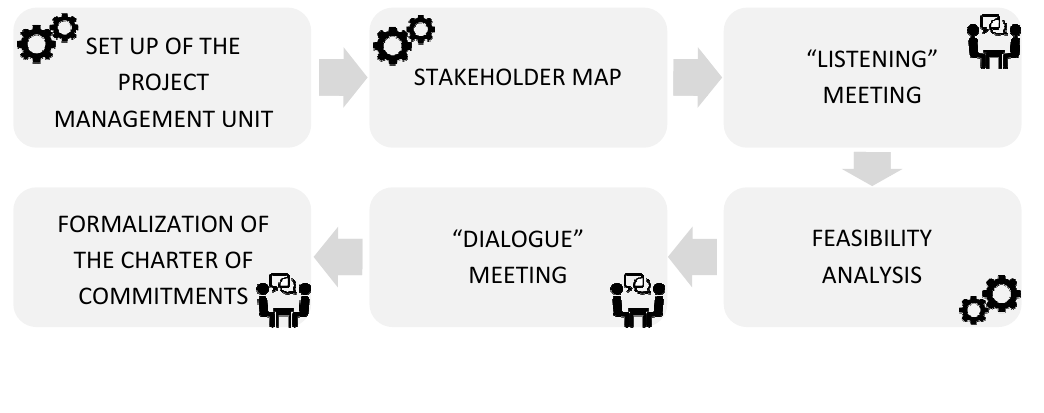
Figure 5: ASPEM Stakeholder Engagement Phases SET UP OF